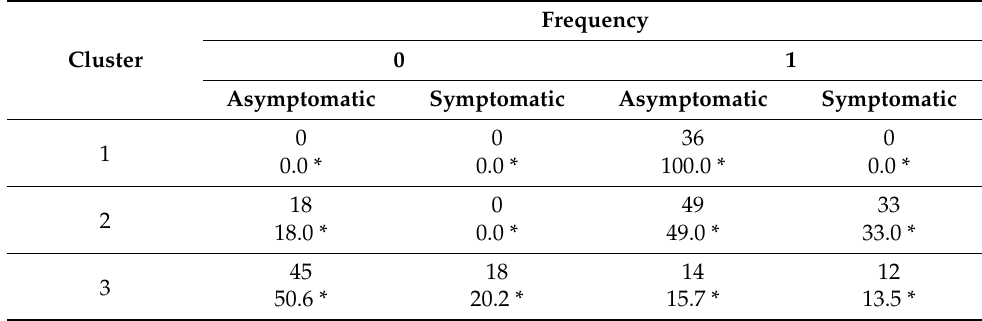
Table 7. Results of unsupervised classification applied to spectral data. Frequency 0 1 Cluster Asymptomatic Symptomatic Asymptomatic Symptomatic 0 0 36 0 1 0.0 * 0.0 * 100.0